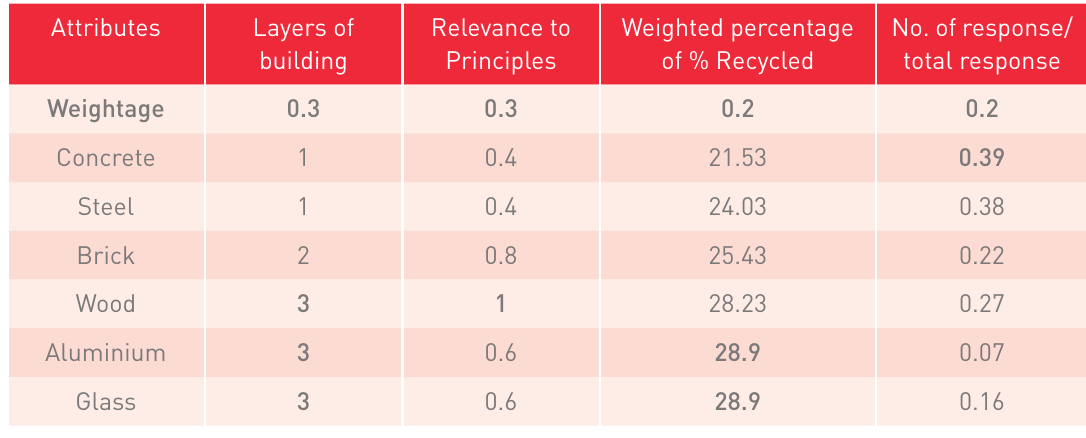
Decision matrix